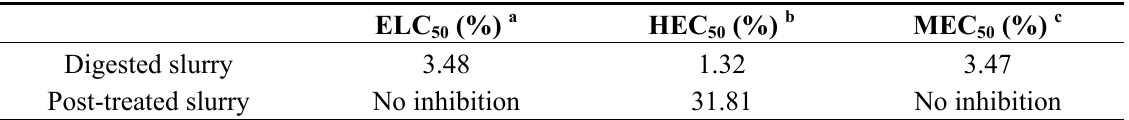
Table 5. Effects of digested and post-treated slurry on mortality, hatching and malformation rate of zebrafish